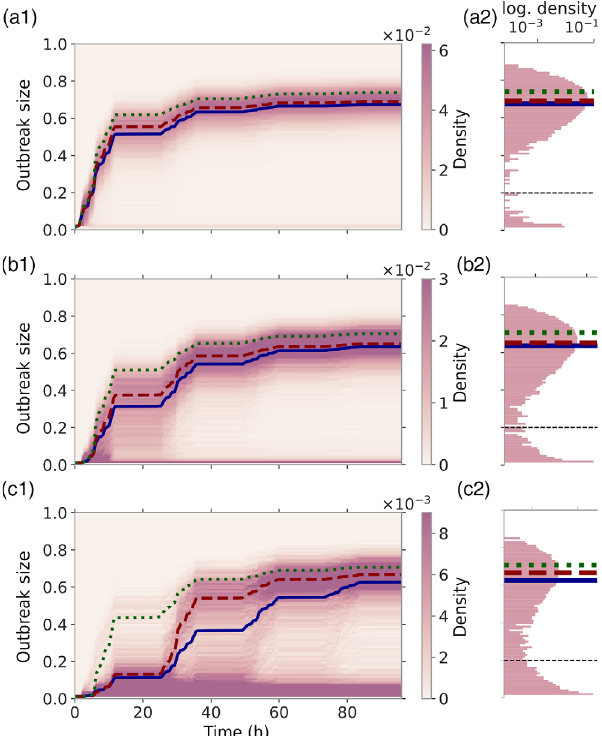
FIG. 3. Left column: Time-resolved and normalized outbreak- size distributions for three different initially infected nodes. Epidemic parameters are as in Fig. 1 and 10 4 MC realizations. The expectation value (blue line) assumes a cutoff at 20% of the population size (black dashed line). The CB and IB models are presented as a red dashed and green dotted line, respectively. Right column: Outbreak-size distribution at the final observation time in logarithmic scale with corresponding expectation values.